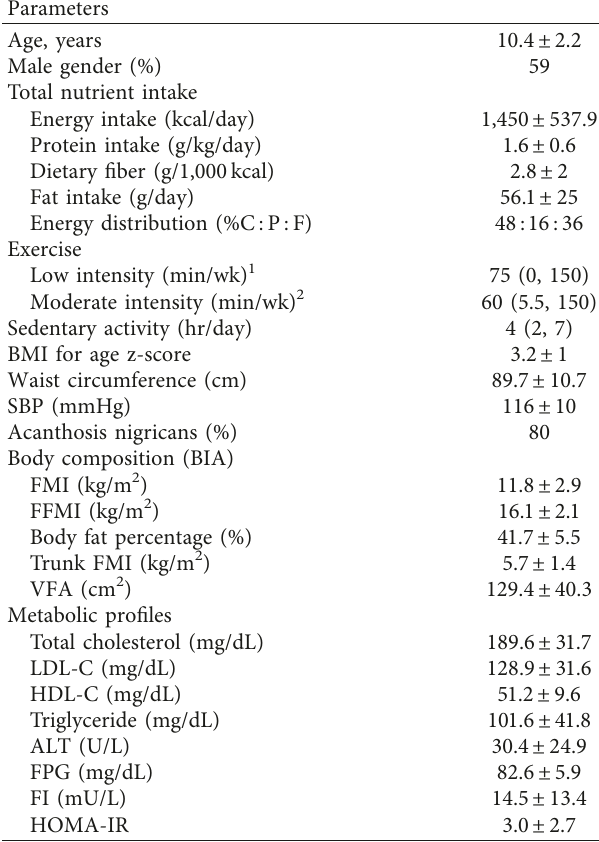
Table 1: Demographic data of obese participants ( n �